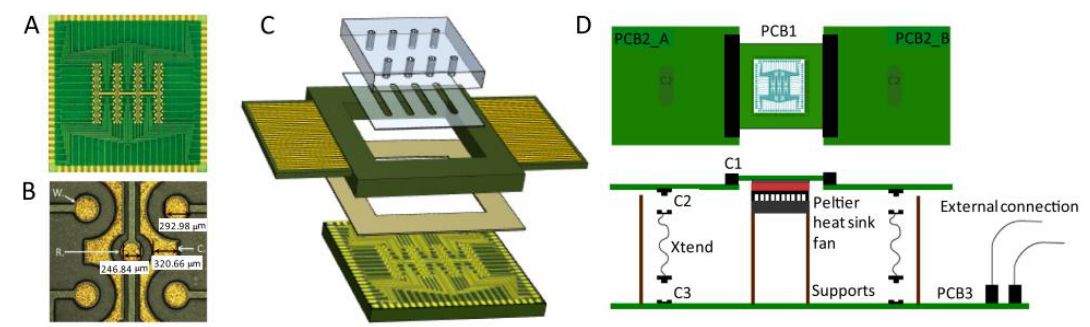
Figure 6. PCB based sensing platform developed for electrochemical detection of cancer-related mRNA markers: ( A ) Electrode arrayed developed using PCB technology; ( B ) magnified image of the PCB electrodes; ( C ) schematic the sensor along with the microfluidic system, and ( D ) fully assembled biosensing platform. The PCB-based chip was a square with a side length of 24.6 mm. The diameter of the working, reference, and counter electrodes was 300, 250, and 250 μ m, respectively. Reproduced with permission from [48] . Copyright 2016 Elsevier.